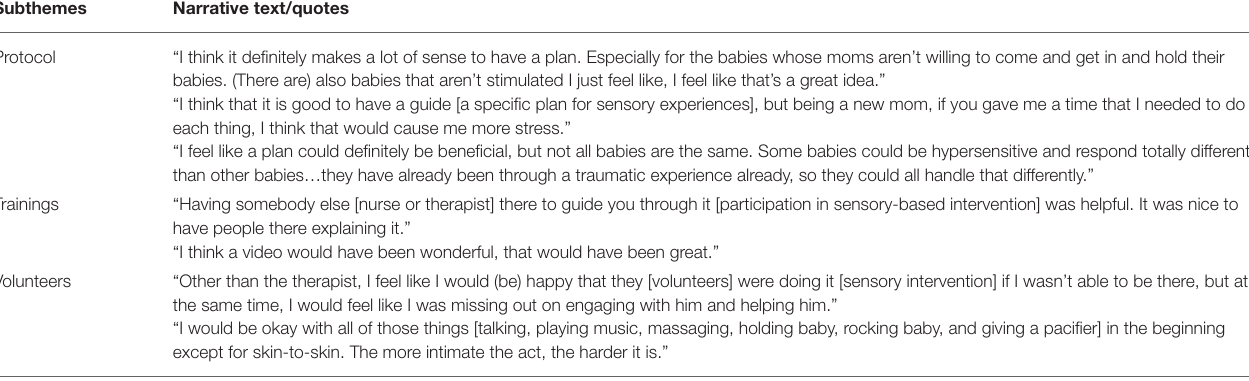
TABLE 3 | Theme 1: Perceptions about development of a sensory-based guideline.